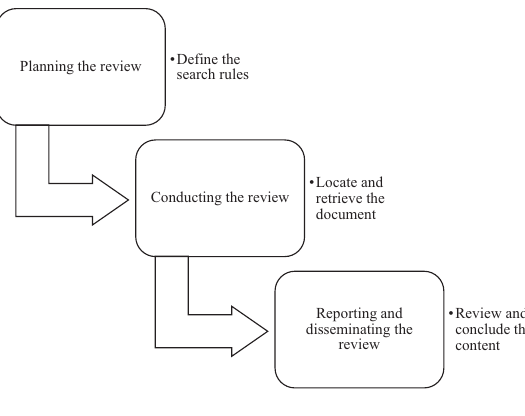
Figure 1. The process